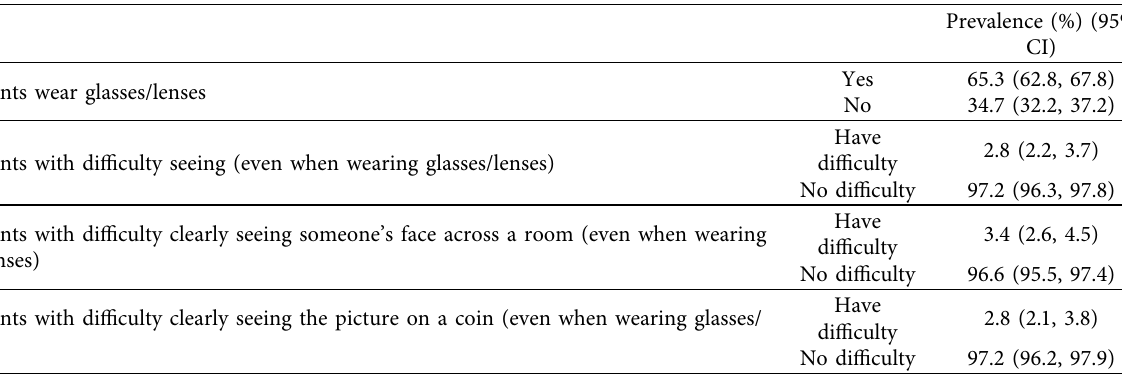
Table 1: Distribution of dependent variables using the Washington Group Extended Question Set on Functioning (WG